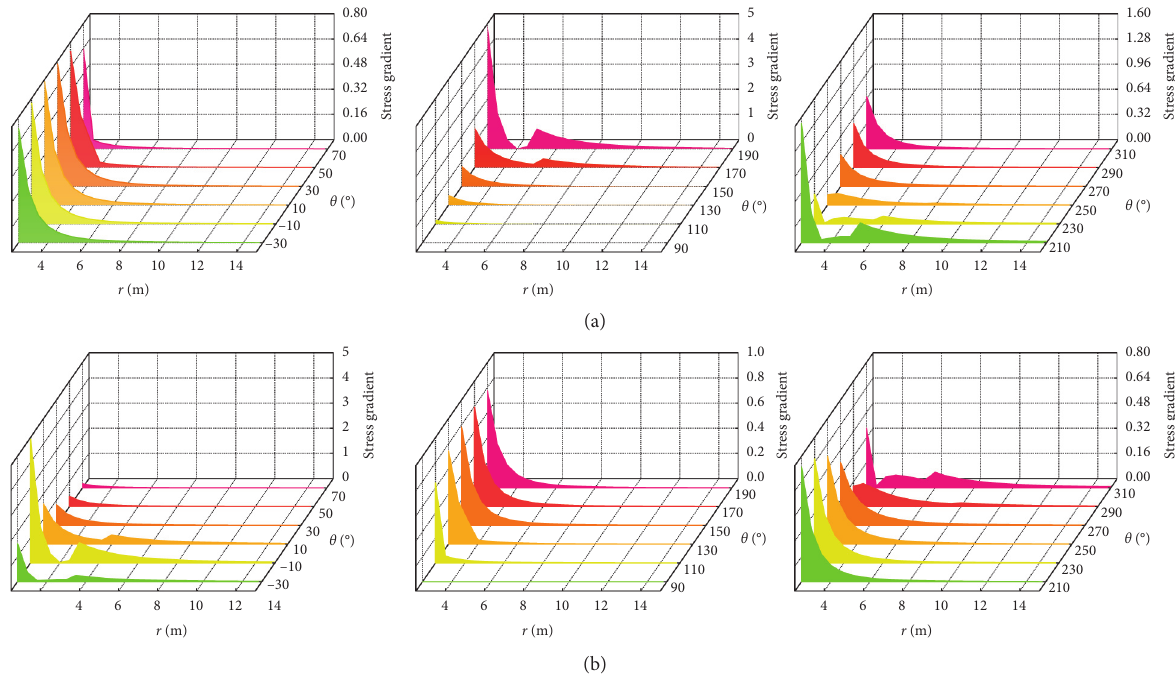
Figure 10: Stress gradient distribution of surrounding rock of roadway. (a) Roof. (b)